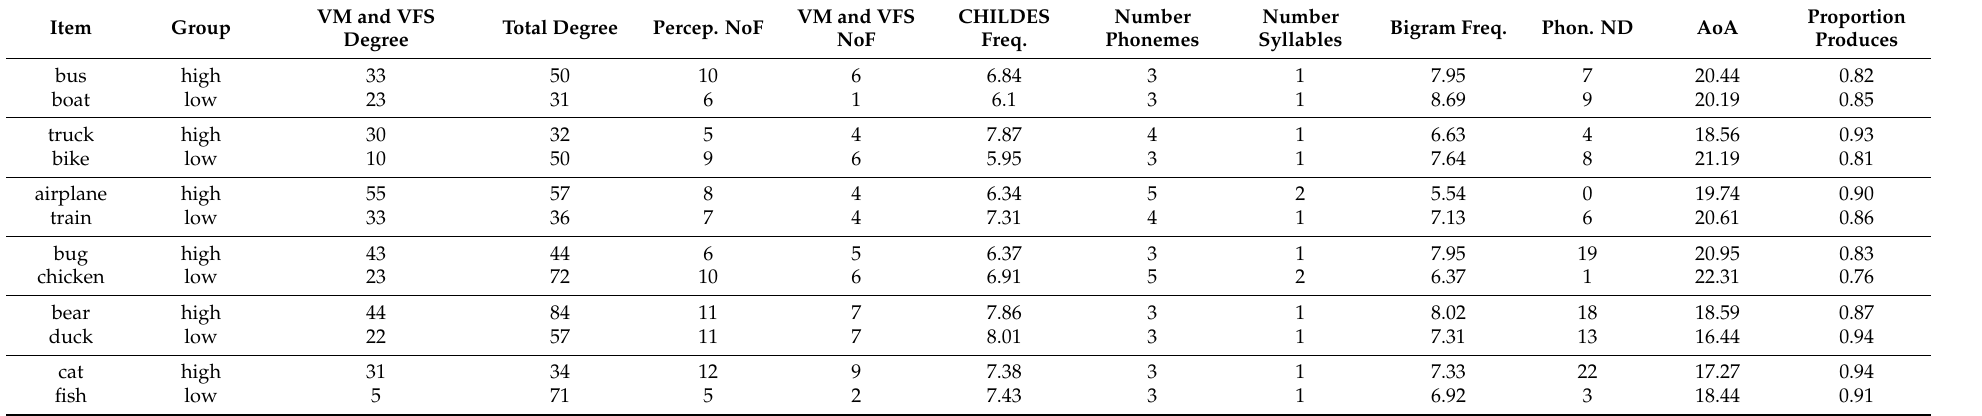
Table A1. Experimental item characteristics.